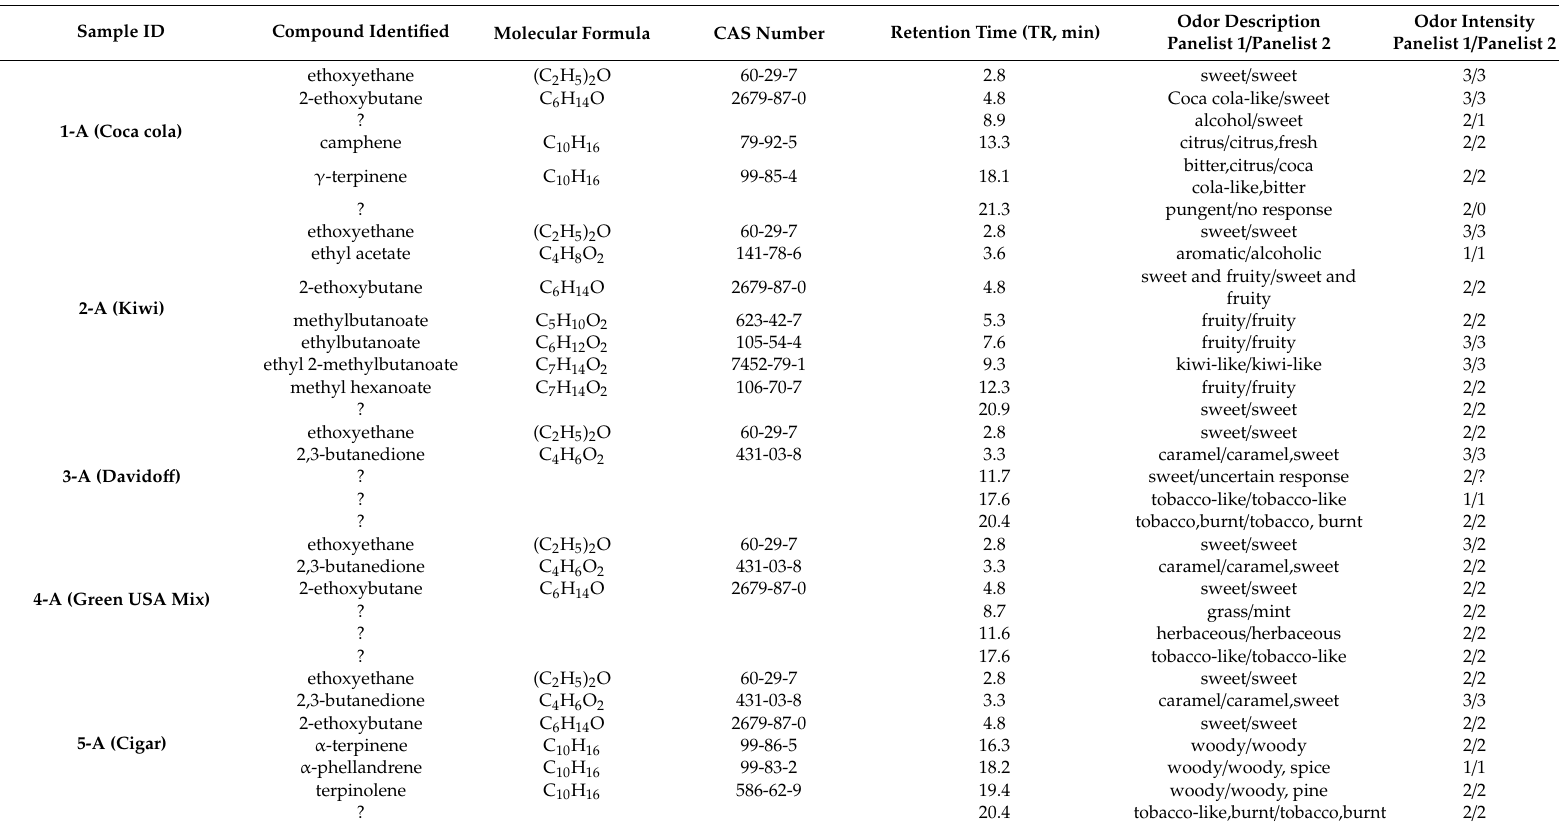
Table 3. Gas chromatography-mass spectrometry-olfactometry (GC-MS-O) report: identified odor-active compounds with specification of molecular formula, CAS number, retention time (TR, min), odor description and